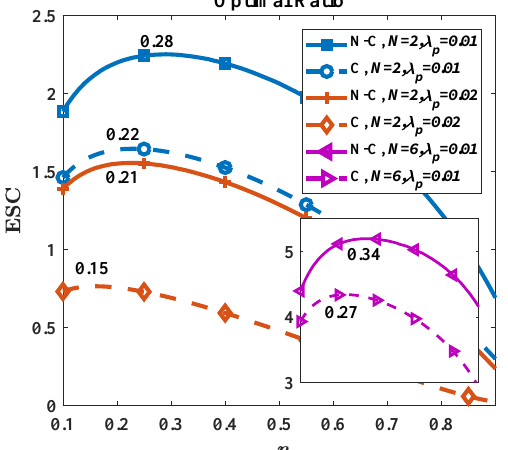
Figure 8. The optimal η under different λ p and N . The solid line describes non-colluding cases while the dashed line describes colluding cases. The main figure for N = 2 while the inset for N = 6. Other parameters are given by: G = 27 dBi; f = 300 GHz; P = − 10 dBm; and R S = 15